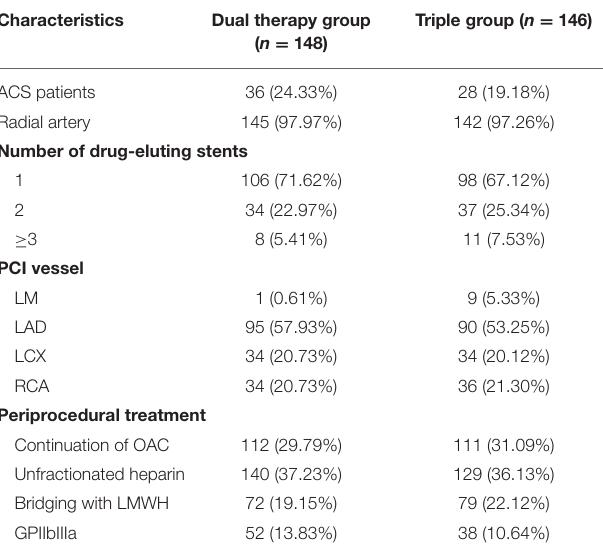
TABLE 2 | Baseline Procedural Characteristics.